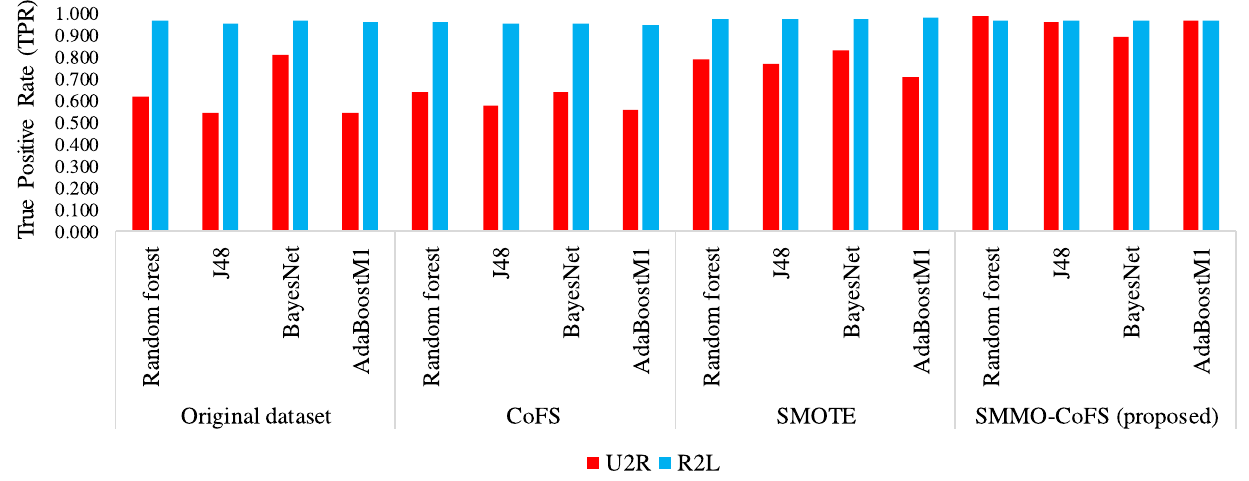
Fig. 4 Performance of SMMO-CoFS with random forest, J48, BayesNet and AdaBoostM1 in terms of TPR for U2R and R2L classes